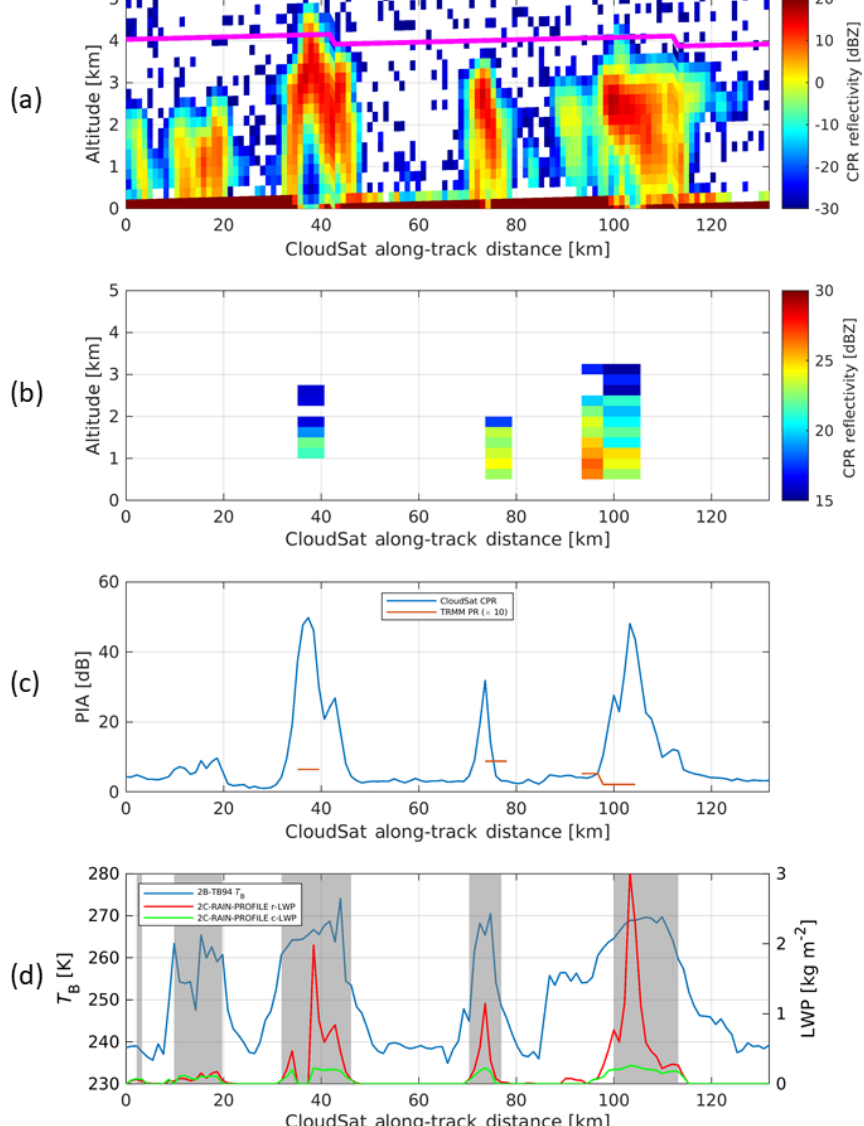
Figure 2. Coincident CloudSat and TRMM satellite overpasses over oceanic warm-rain cells (2 January 2008, 07:46:46–07:47:05UTC). (a) Vertical profile of CloudSat radar reflectivities with the magenta line indicating the freezing level height. (b) TRMM PR reflectivities. (c) CloudSat and TRMM (multiplied by 10) two-way PIA SRT ’s (PIA SRT denotes PIA via the surface reference technique). (d) CloudSat brightness temperature. The shaded regions correspond to profiles of warm rain as identified by